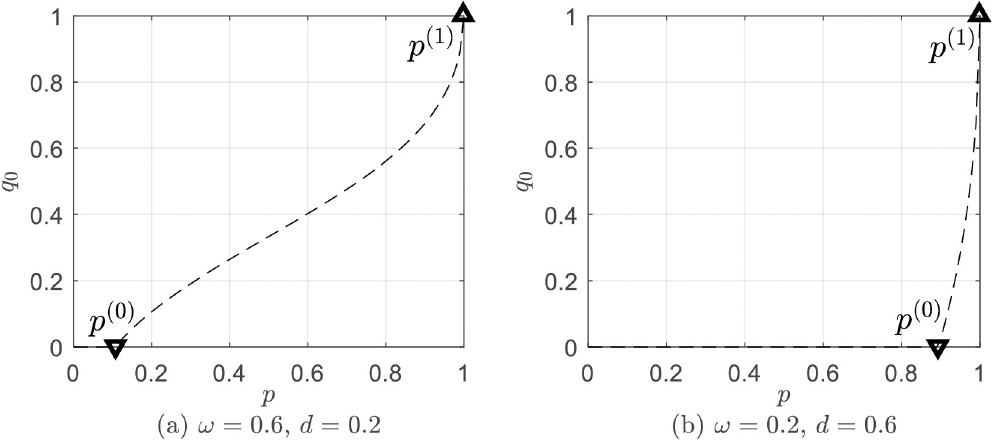
Fig 4. The optimal proportion of recovery resources q 0 assigned to the active informed people as a function of p , when μ = 0.01. (a) ω = 0.6, d = 0.2. (b) ω = 0.2, d = 0.6.